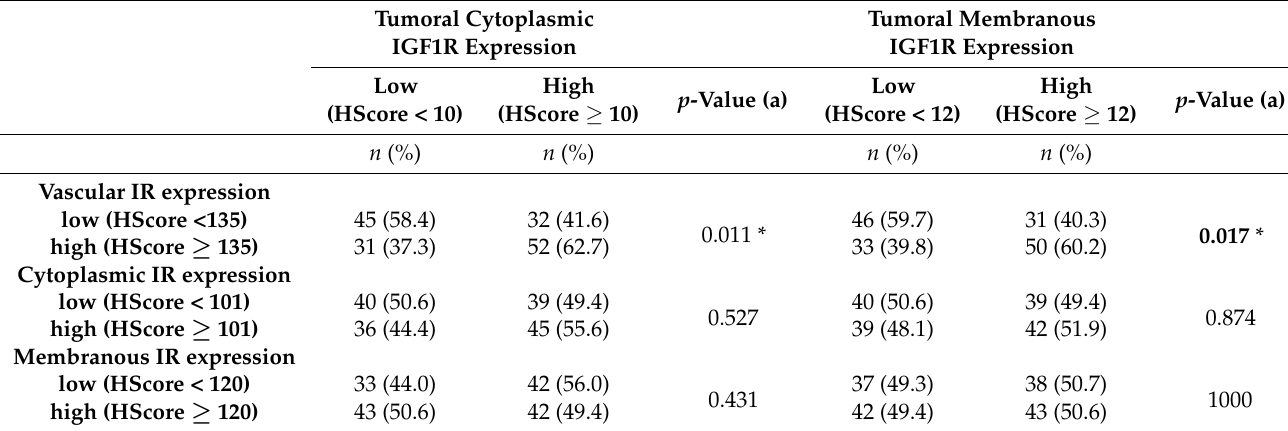
Table 3. Correlation between the expression of the insulin-like growth factor receptor 1 (IGF1R) and the insulin receptor (IR) in cancer cells and